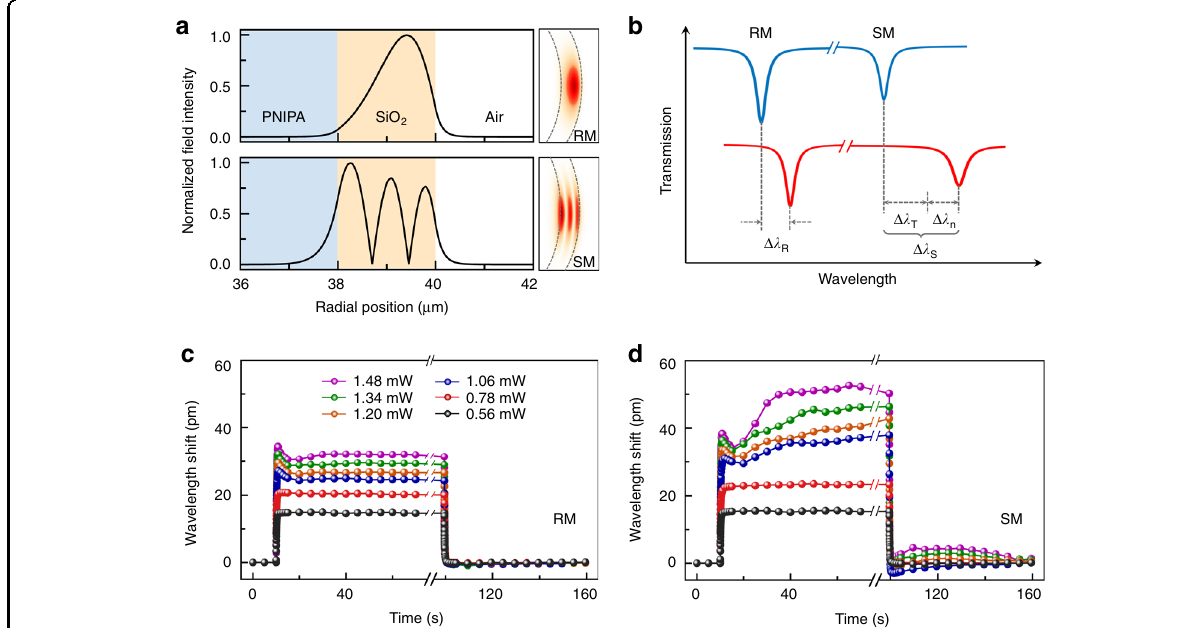
Fig. 2 Concept of self-referencing WGM sensors. a Electrical fi eld (|E|) distribution of reference mode (RM) and sensing mode (SM) by fi nite- element-method simulation. b Schematic of self-referencing strategy with dual-WGMs sensing method, where Δ λ T = ( β 2 / β 1 ) ⋅ Δ λ R . c , d Real-time wavelength shifts of reference mode and sensing mode at different heating power and natural cooling (@ 22 °C),